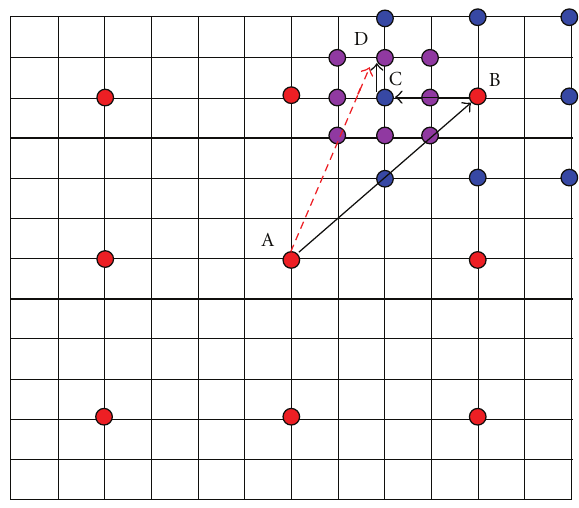
Figure 7: An example of “three-step search”